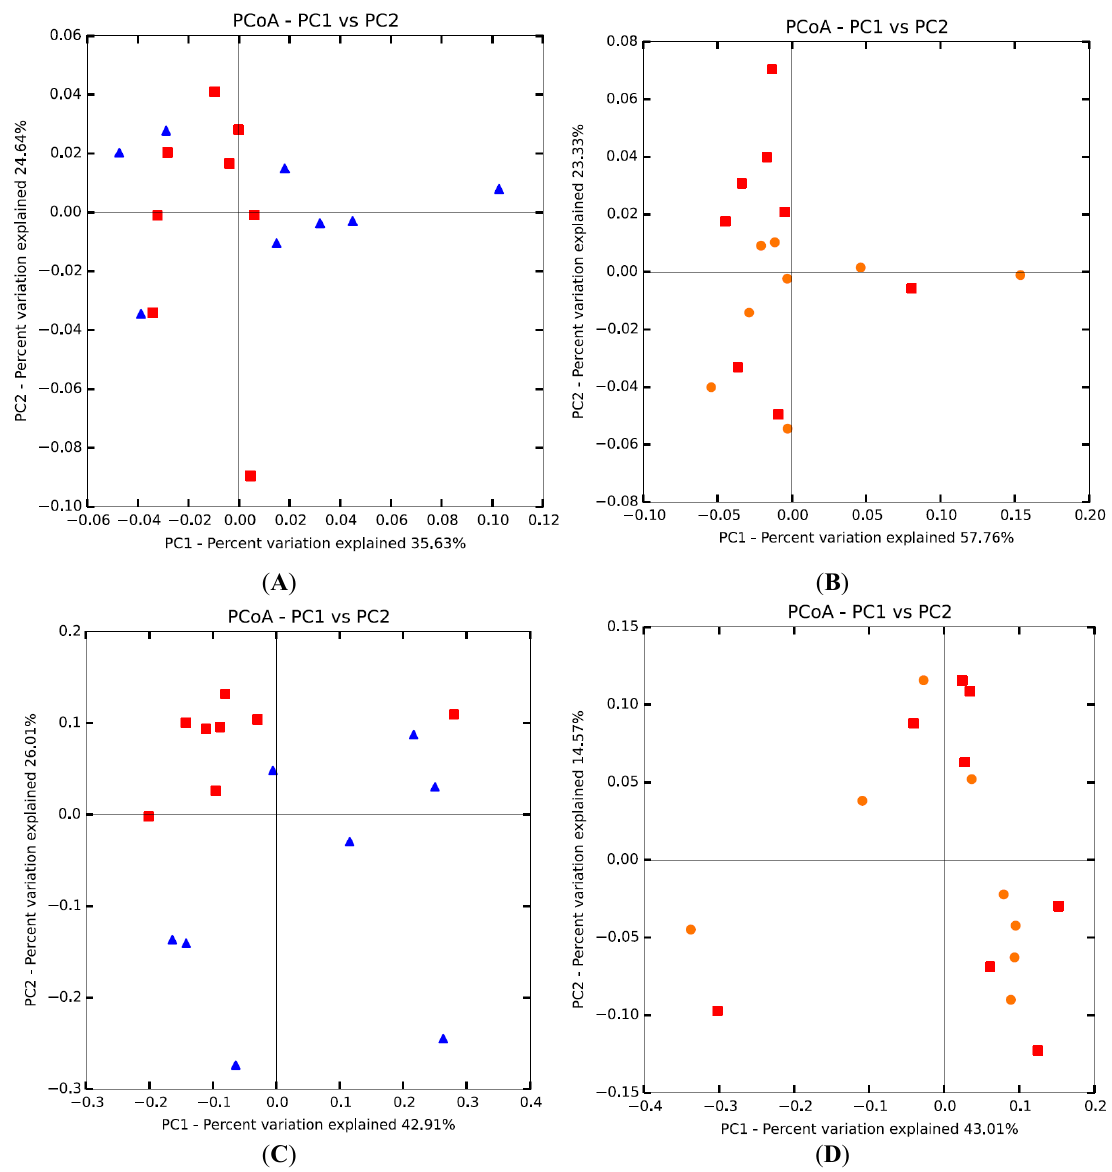
Figure 1. Principal co-ordinates analysis of the diversity of the ileal digesta ( A and B ) and cecal content ( C and D ) microbiota based on weighted UniFrac distances. Abscissa represents the first principal component, ordinate represents the second principal component. Percentage represents the contribution of the principal component to the total variance. Red square = uninfected group; blue triangle = infected group; orange circle = infected + probiotic group.